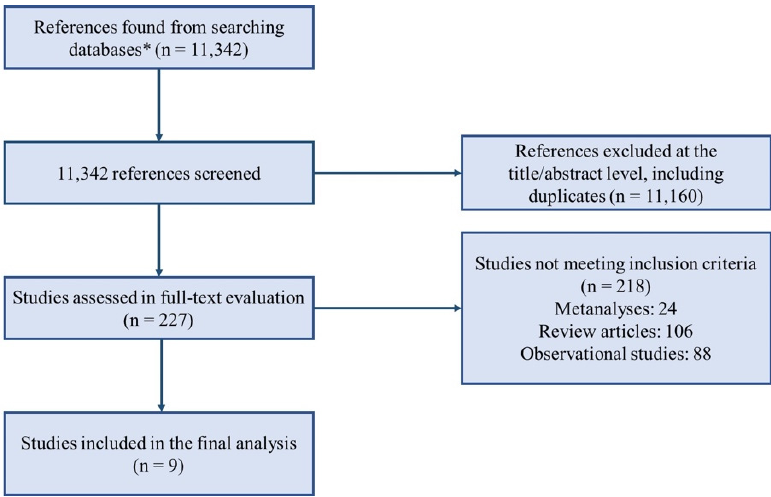
Figure 1. Evidence search and selection of the preferred reporting items for systematic reviews and meta-analyses (PRISMA). * Medline, Cochrane, Journals@Ovid,